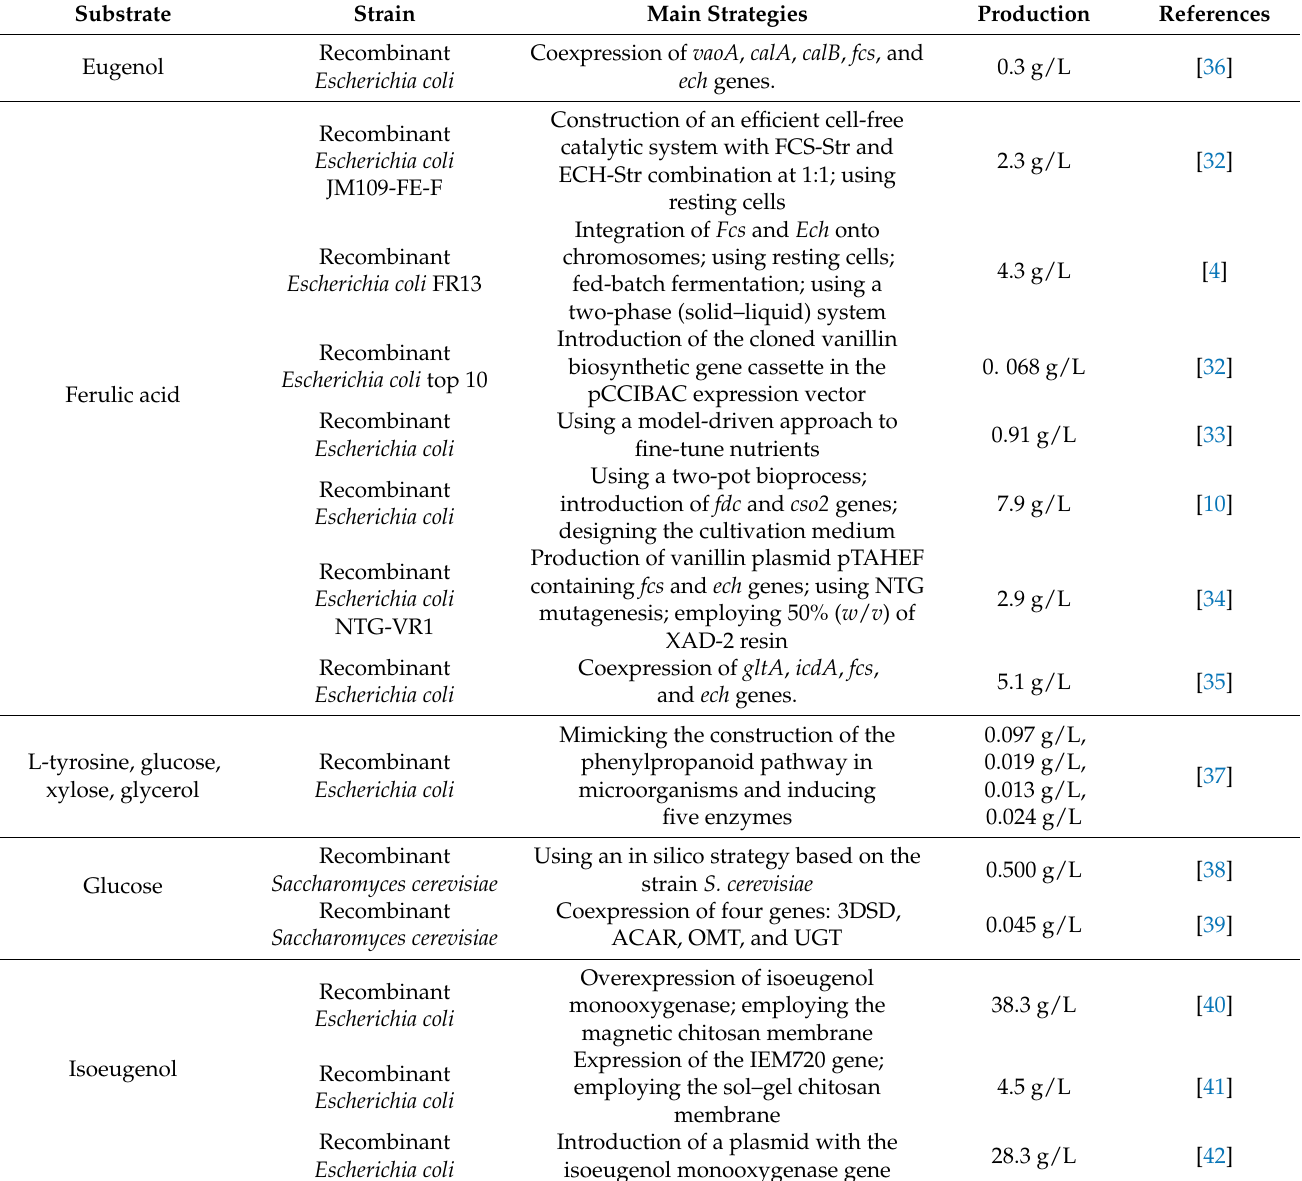
Table 1. Synthesis of vanillin using engineered